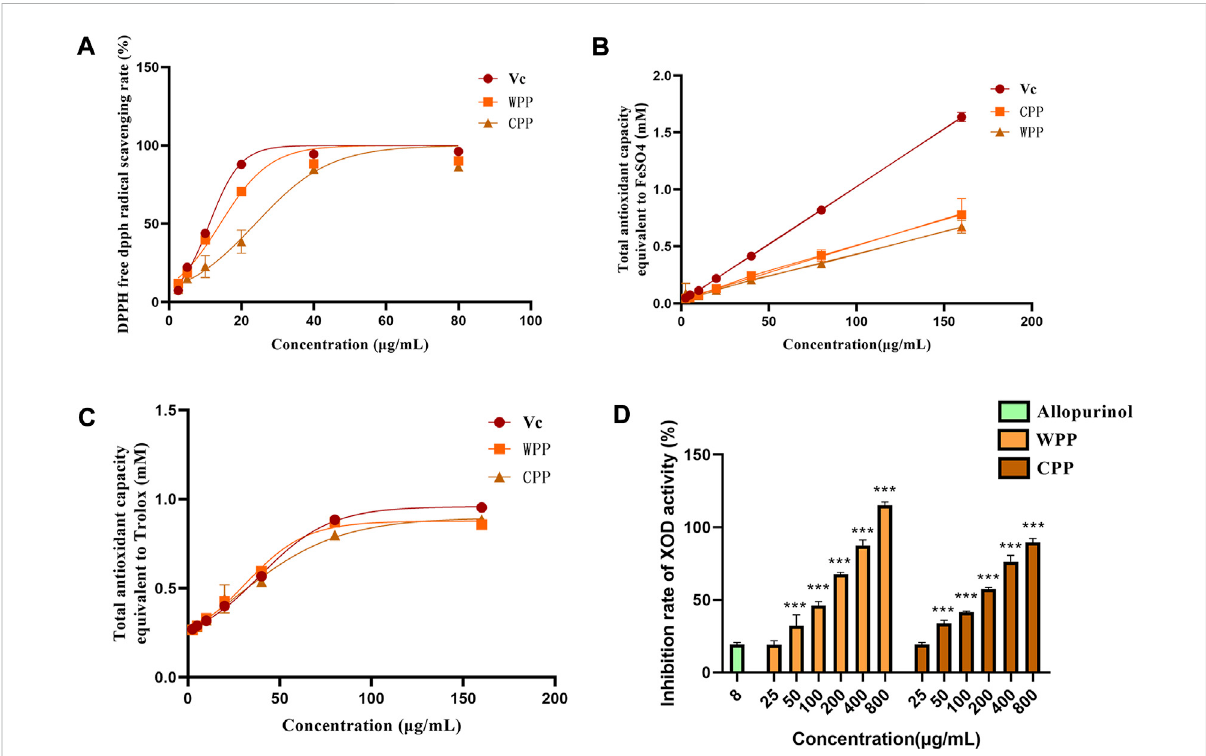
FIGURE 1 Comparison of DPPH free radical scavenging rates between WPP and CPP (A) , comparison of FRAP values between WPP and CPP (B) , and comparison of ABTS values between WPP and CPP (C) . Comparison of inhibitory effects of WPP and CPP on XO, *** p < 0.001 vs. allopurinol (8 μ g/ ml), n = 4 (D)